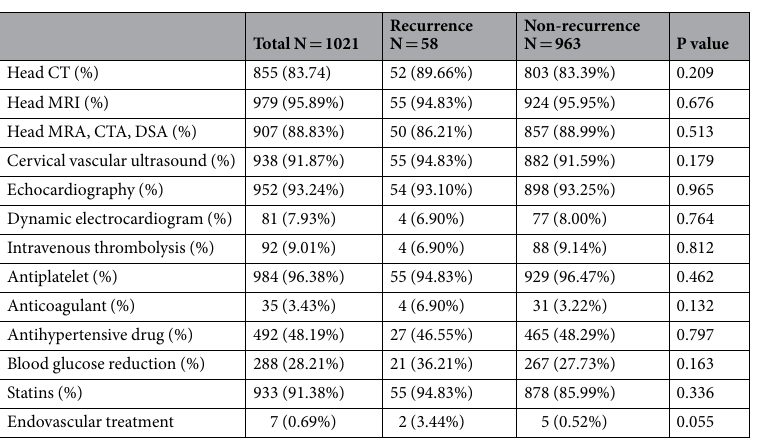
Table 3. Comparison of the diagnosis and treatment measures between the two groups of